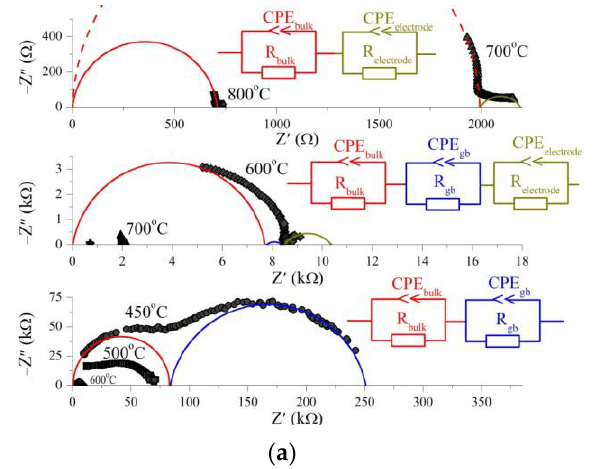
Figure 5. The Nyquist plots for the sample La 1.9 Ca 0.1 ScZnO 5.45 . ( a ) Evolution of the spectra with tem- perature in dry air (pH 2 O = 3.5·10 −5 atm) and corresponding equivalent circuits; ( b ) evolution of the spectra with water vapor partial pressure pH 2 O = 2·10 −2 atm (open signs) and pH 2 O = 3.5·10 −5 atm (closed signs) at 400 °C.